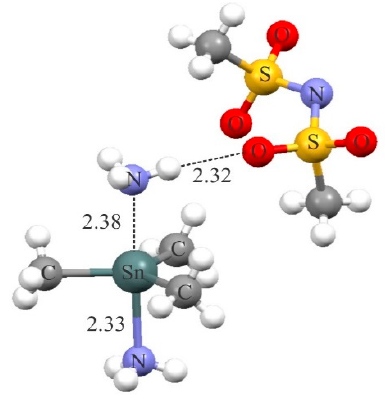
Figure 8. Crystalline structure ofthe[Sn(Me) 3 (NH 3 ) 2 ][N(SO 2 Me) 2 ] complex.